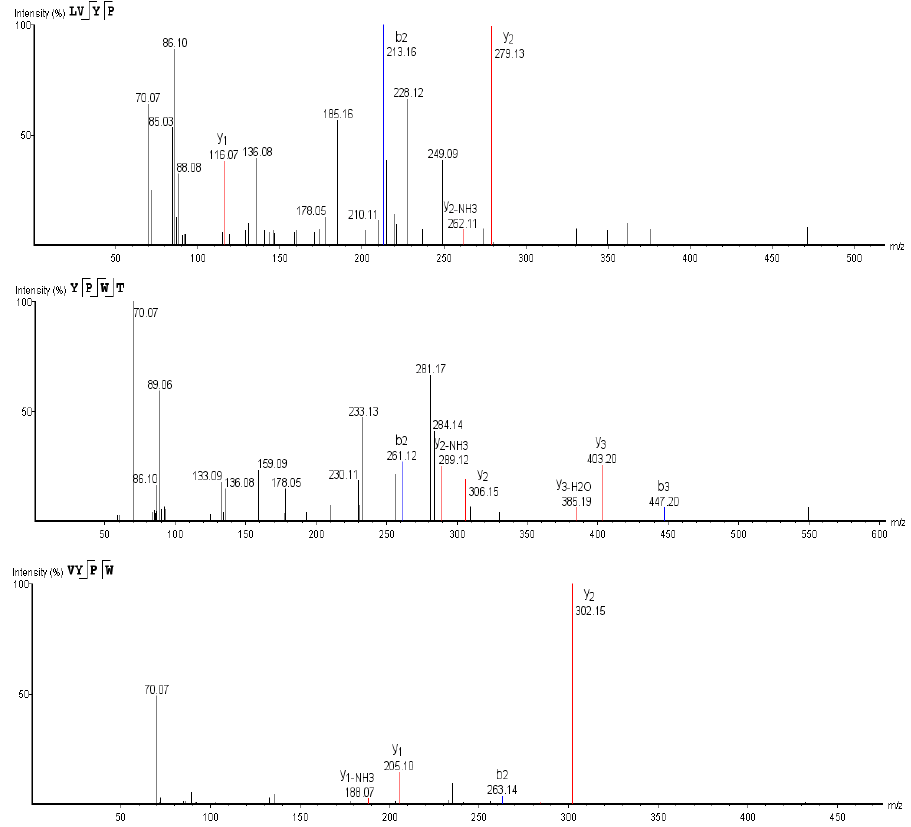
Figure 12. Primary mass spectra of three novel ACE inhibitory peptides .